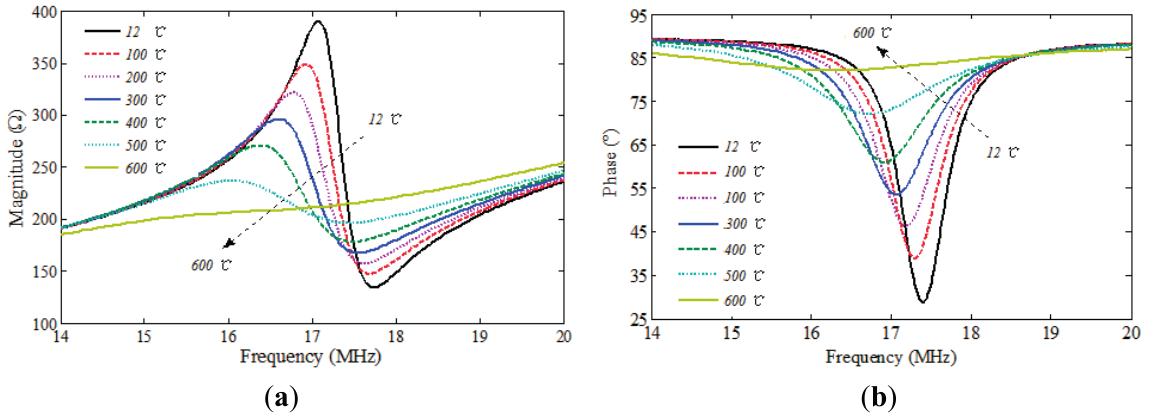
Figure 7. The magnitude ( a ) and phase ( b ) of impedance versus frequency over 12 °C – 600 °C temperature range.